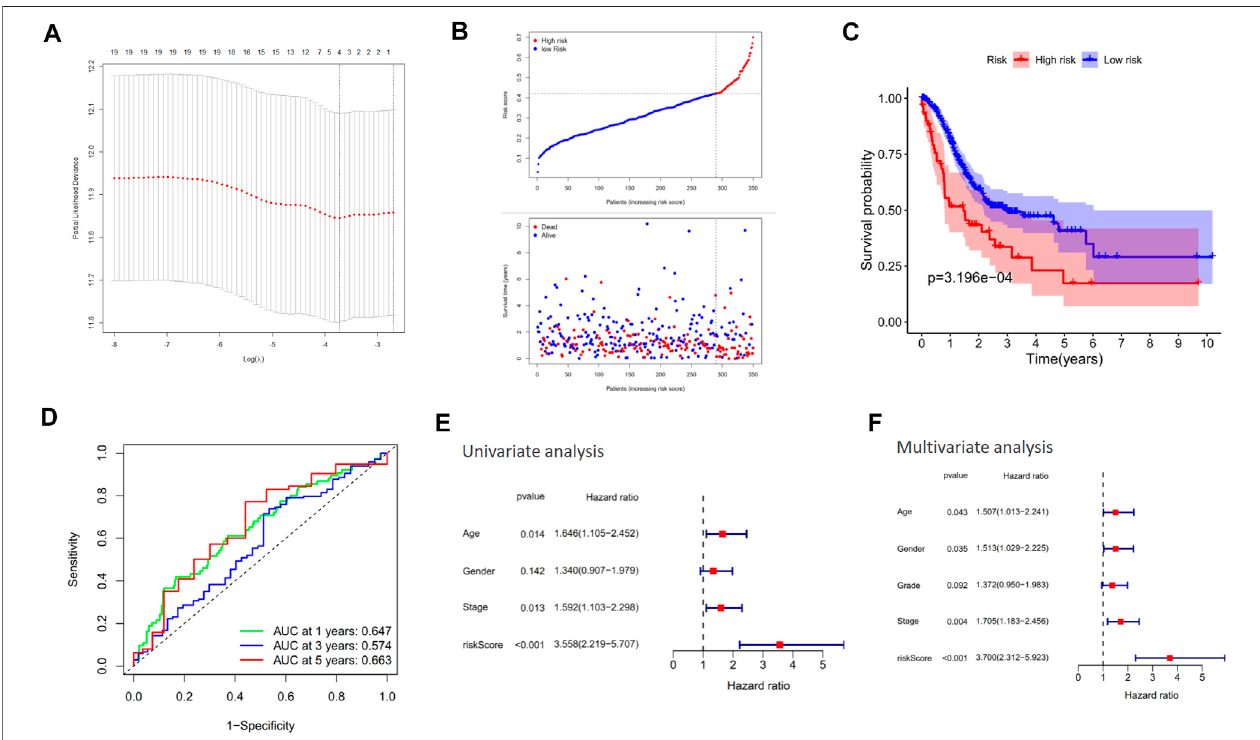
FIGURE 7 | Construction of a CXCR4-related prognostic model. (A) Cross-validation for tuning parameter selection in the proportional hazard model. (B) Distribution of risk score in the TCGA cohort. (C) Kaplan – Meier survival analysis of OS between the high-risk group and low-risk group in the TCGA cohort. (D) AUC in ROCanalysisforrisksignatureat1-,3-,and5-yearsurvivaltimeintheTCGAcohort. (E,F) ResultsoftheunivariateandmultivariateCoxregressionanalysesofOSinthe TCGA